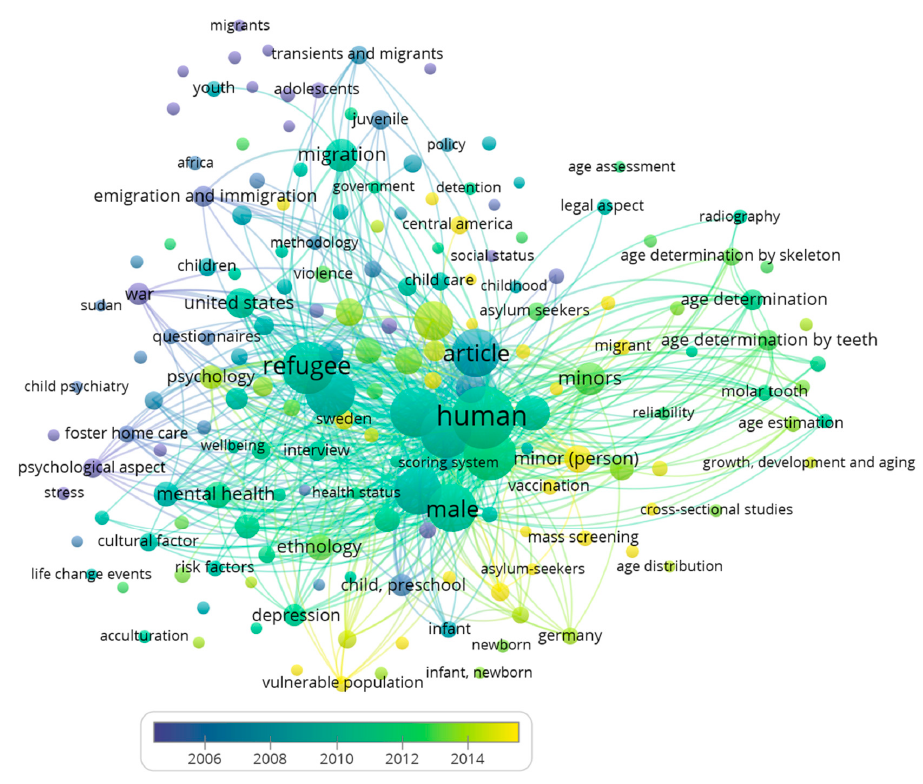
Figure 10. Time evolution of keyword groups on unaccompanied minors’ work.